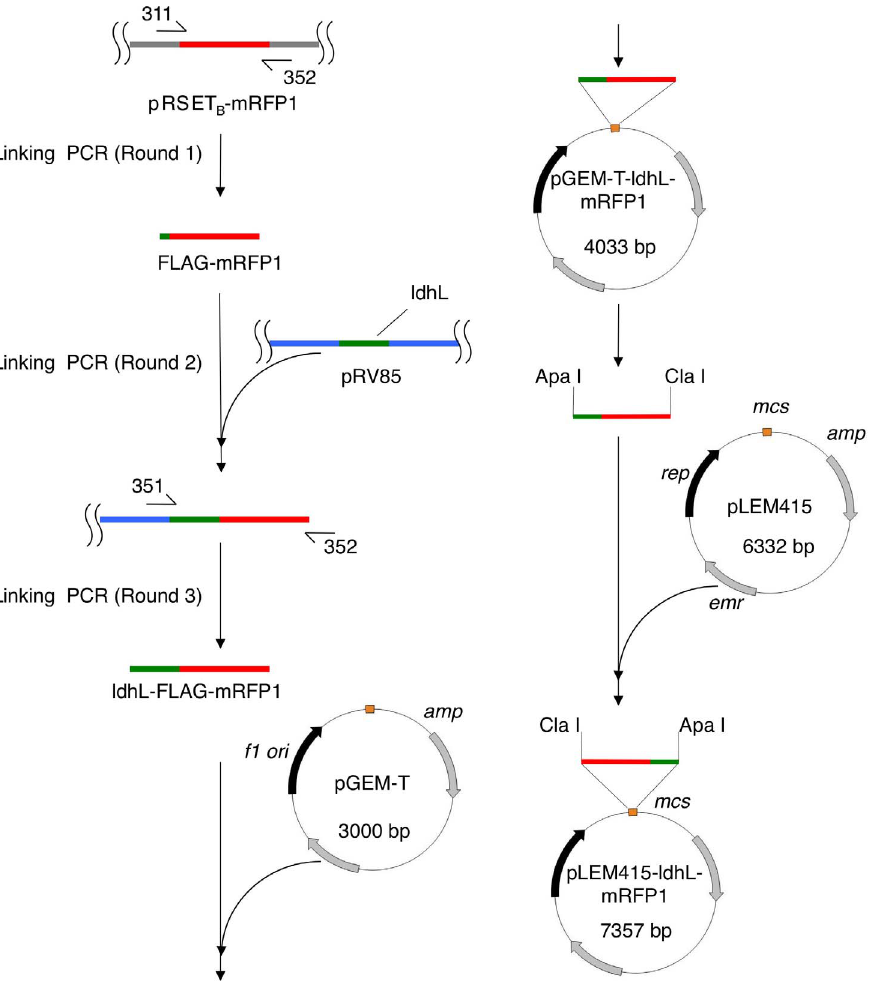
Figure 1. Construction of Lactobacillus-based expression vectors. To generate pLEM415-ldhL-mRFP1, the ldhL promoter and FLAG-mRFP1 were joined by using a 3-round linking PCR technique. The resulting ldhL-FLAG-mRFP1 fragment was then cloned into pGEM-T. Finally, the fragment was released from pGEM-T and cloned into pLEM415. Other expression vectors described in this work were generated in a similar manner. Refer to Materials and Methods for details.